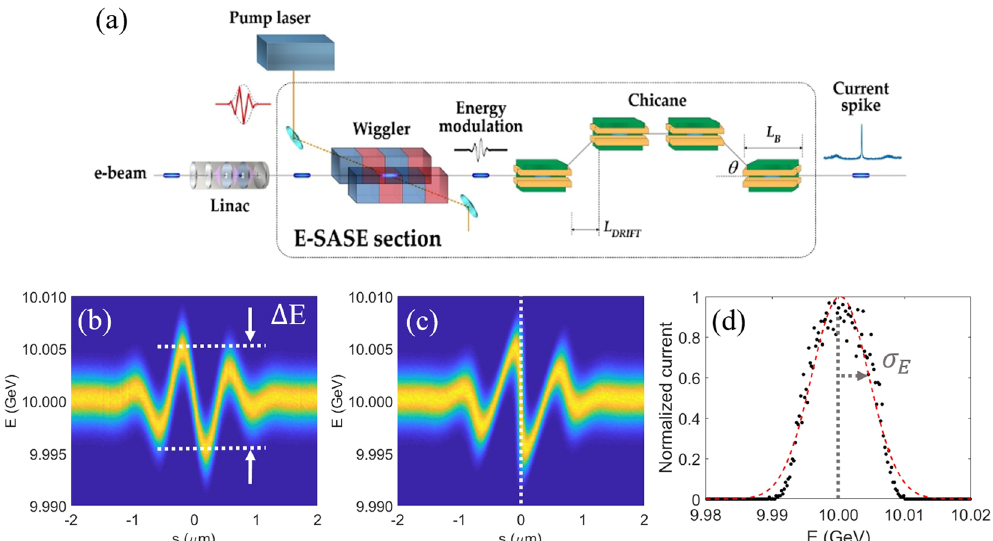
Figure 8. ( a ) Schematic view of the E-SASE method. Energy distribution of an electron beam ( b ) after wiggler and ( c ) after chicane in the E-SASE section. ( d ) Energy distribution (black dots) of the electrons in a selected slice depicted by a white vertical dashed line in Fig. 8(c); red line: fitting line with Gaussian